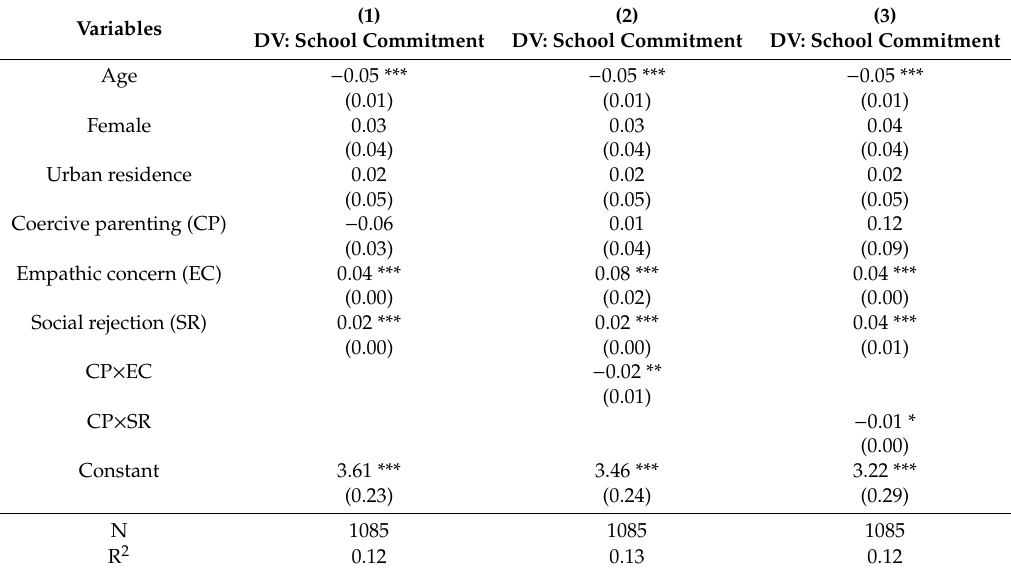
Table 4. Regression coe ffi cients of explanatory variables on school